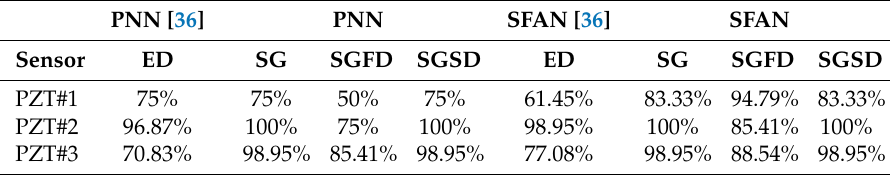
Table 2. Success rates for PNN and SFAN methods for impedance signals in the time domain.